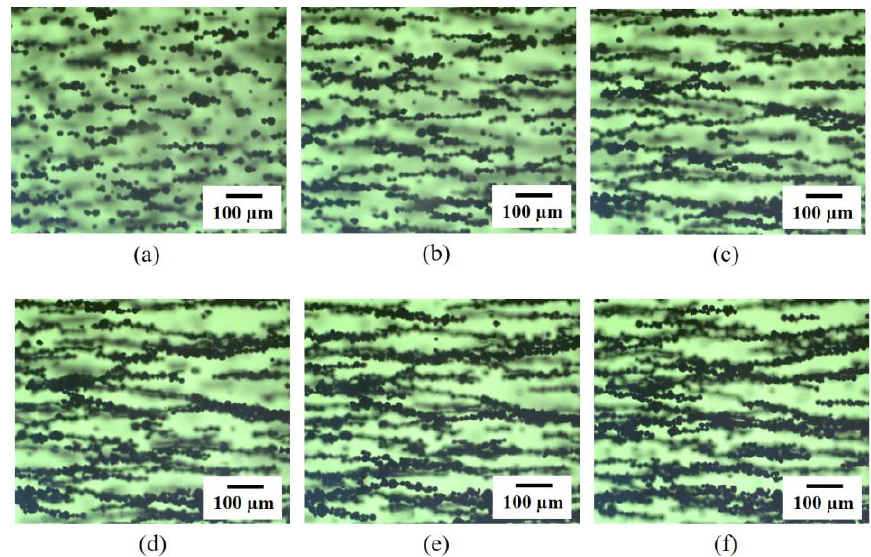
Figure 3. Alignment process of SNP in the matrix (10 vol.%) with magnetization times: ( a ) 1 second; ( b ) 5 seconds; ( c ) 10 seconds; ( d ) 15 seconds; ( e ) 20 seconds; and ( f ) 25 seconds.